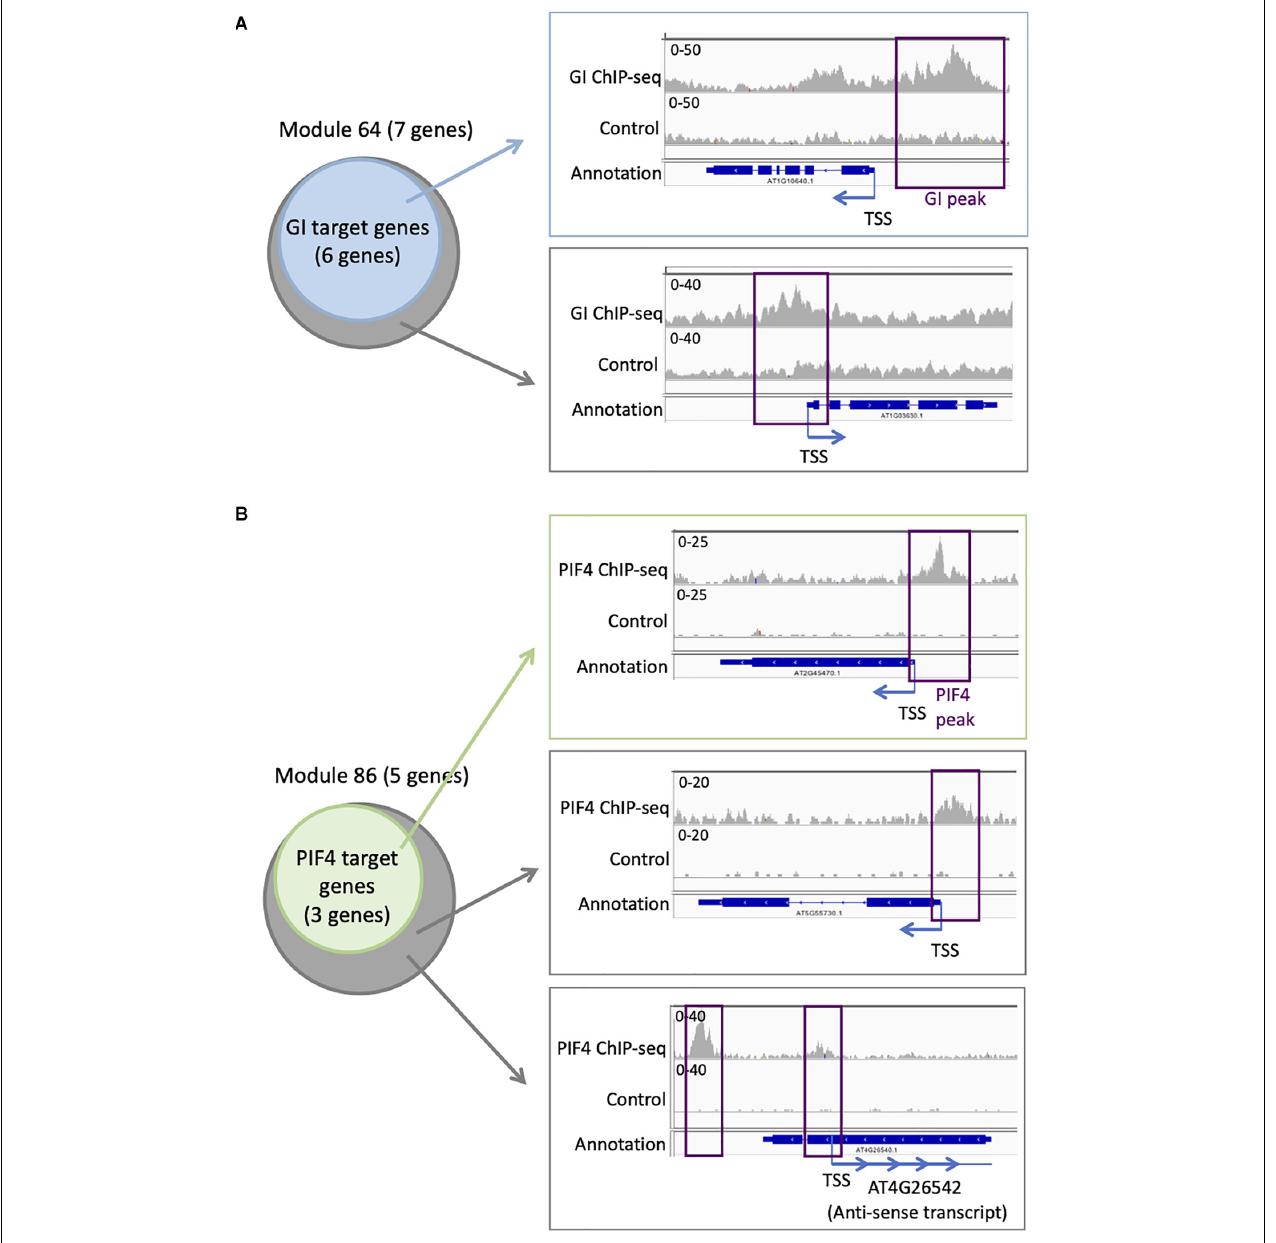
FIGURE 5 | Additional TF targets can be identified using TF target enrichment in modules. (A) Analysis of GI transcriptional regulator targets on module 64: six of the seven genes in module 64 are known targets of GI (left). IGV screenshot showing the signal for the GI ChIP-seq (right) at a known GI target (top) and for the seventh gene in module 64 that is not known as a GI target (bottom). (B) Analysis of PIF4 TF targets on module 86: three of the five genes in module 86 are known targets of PIF4 (left). IGV screenshot showing the signal for the PIF4 ChIP-seq (right) at a known PIF4 target (top) and for the two other genes in module 86 that are not known as a PIF4 target